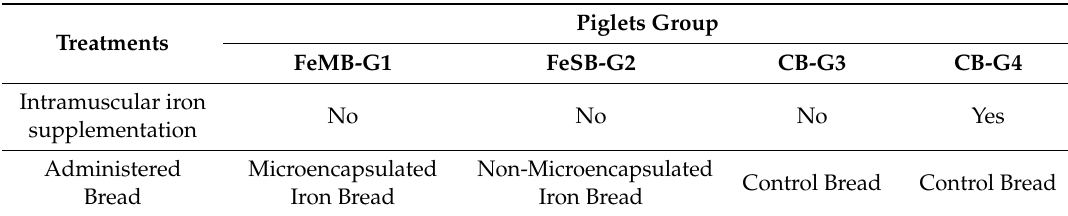
Table 1. Experimental